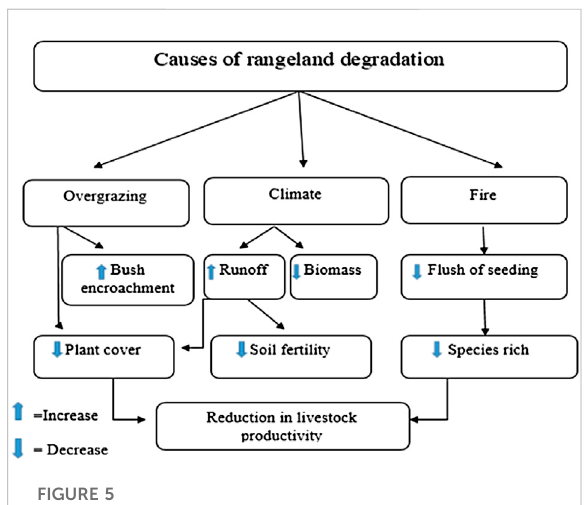
FIGURE 5 The schematic presentation of the process of degradation. Adopted from Ravhuhali